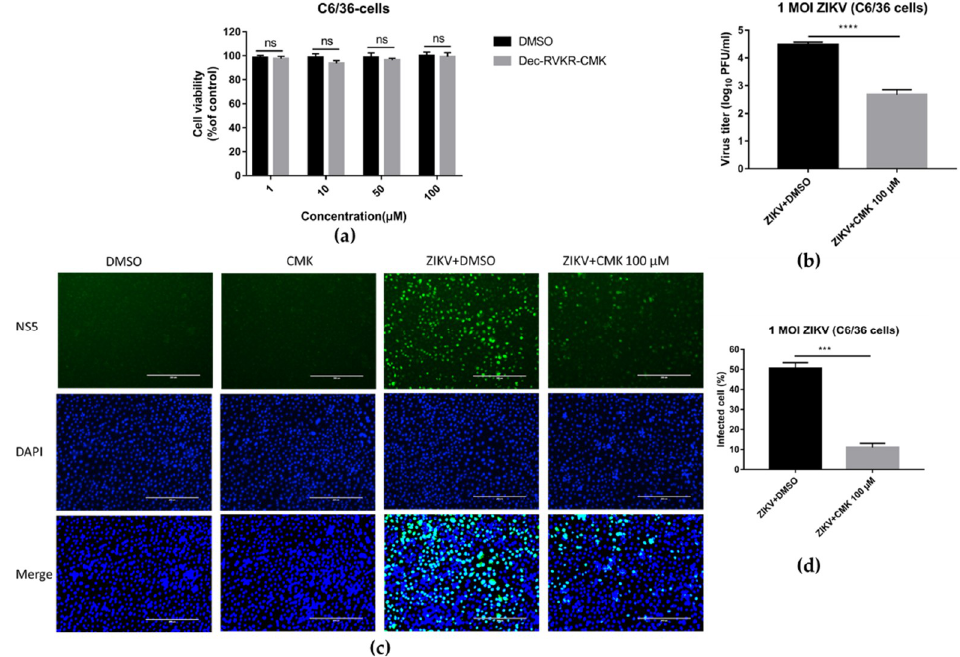
Figure 8. Dec-RVKR-cmk inhibits ZIKV and JEV infection in mosquito cell line C6 / 36. ( a ) Cytotoxicity of dec-RVKR-cmk in C6 / 36 cell line was determined by CellTiter-GLO One Solution Assay kit (Promega). ( b ) C6 / 36 cells were infected with ZIKV (1 MOI) followed by dec-RVKR-cmk treatment using the 100 µ M concentration. Cell supernatant was used to determine ZIKV viral titer by plaque assay at 24 hpi. ( c ) Immunofluorescence images of ZIKV-infected c6 / 36 cells were acquired to quantify ( d ) ZIKV immunoreactive positive cells. Data are presented as the mean ± SEM from three independent experiments.